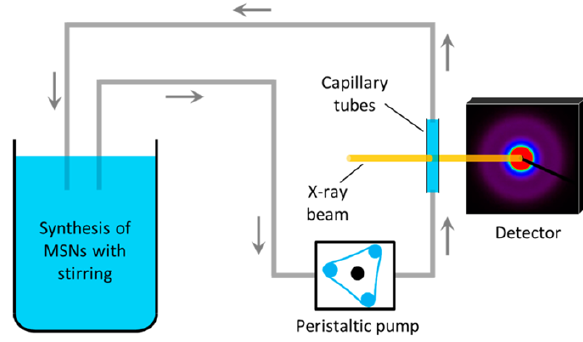
Figure 14: SAXS setup to dynamically monitor the growth of MSNs under different experimental conditions. The temperature of the reservoir for fabricating MSNs was controlled by a water bath with magnetic stirrer. The circulated reaction liquid came from the bot- tom of capillary tubes to the top in order to eliminate any influence of bubbles generated by the influent fluidic flow